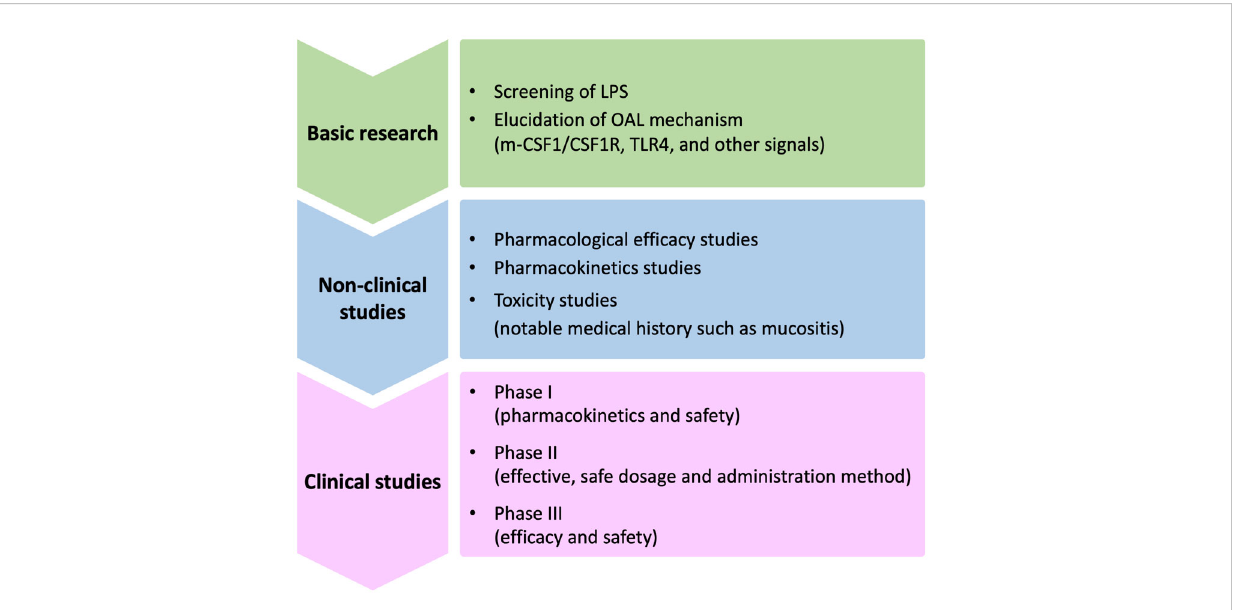
FIGURE 2 Issues to be solved for clinical application of OAL. Issues to be resolved in the future for clinical application of OAL can be broadly divided into basic research, non-clinical studies, and clinical studies. First, in basic research, the OAL mechanism involving CSF1R signaling must be elucidated. It will also be important to extract LPS with high ef fi cacy through LPS screening. Next, in non-clinical studies, it is necessary to improve the safety and ef fi cacy of OAL through pharmacological, pharmacokinetic, and toxicity studies. Safety in patients with speci fi c and noteworthy medical histories such as mucositis must also be veri fi ed there. Based on the above studies, in the fi nal clinical trial, it is necessary to con fi rm the safety and ef fi cacy in humans and determine the optimal dosage. OAL, oral administration of LPS; m-CSF1, membranous colony stimulating factor 1; CSF1R, CSF1 receptor; TLR4, toll-like receptor